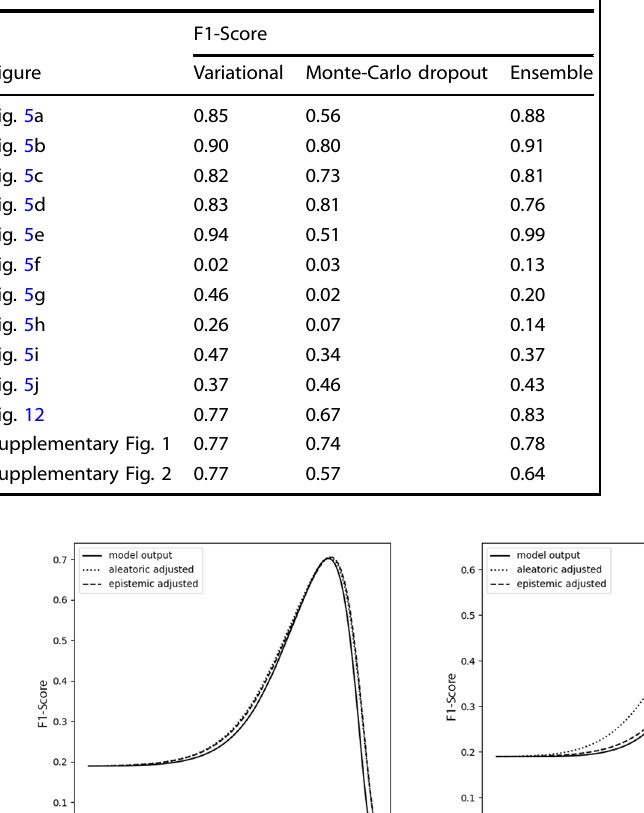
Table 2. F1-scores measured from the output with threshold = 0.75.